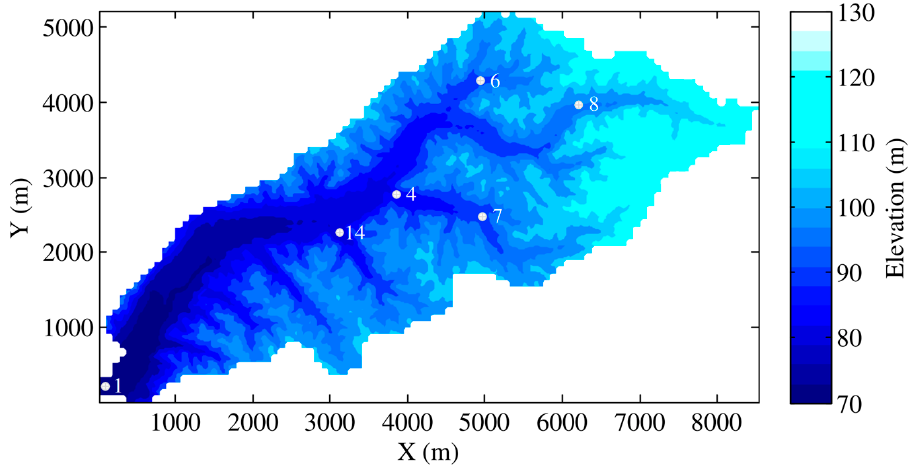
Figure 16. The Goodwin Creek Experimental Watershed.